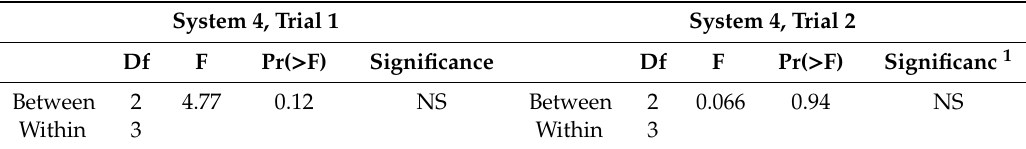
Table 3. Statistical analysis (ANOVA) of the plant yield between System 4 growbeds (Trial 1 and Trial 2), which were subjected to different flow rates (500, 160 and 40 L/h).